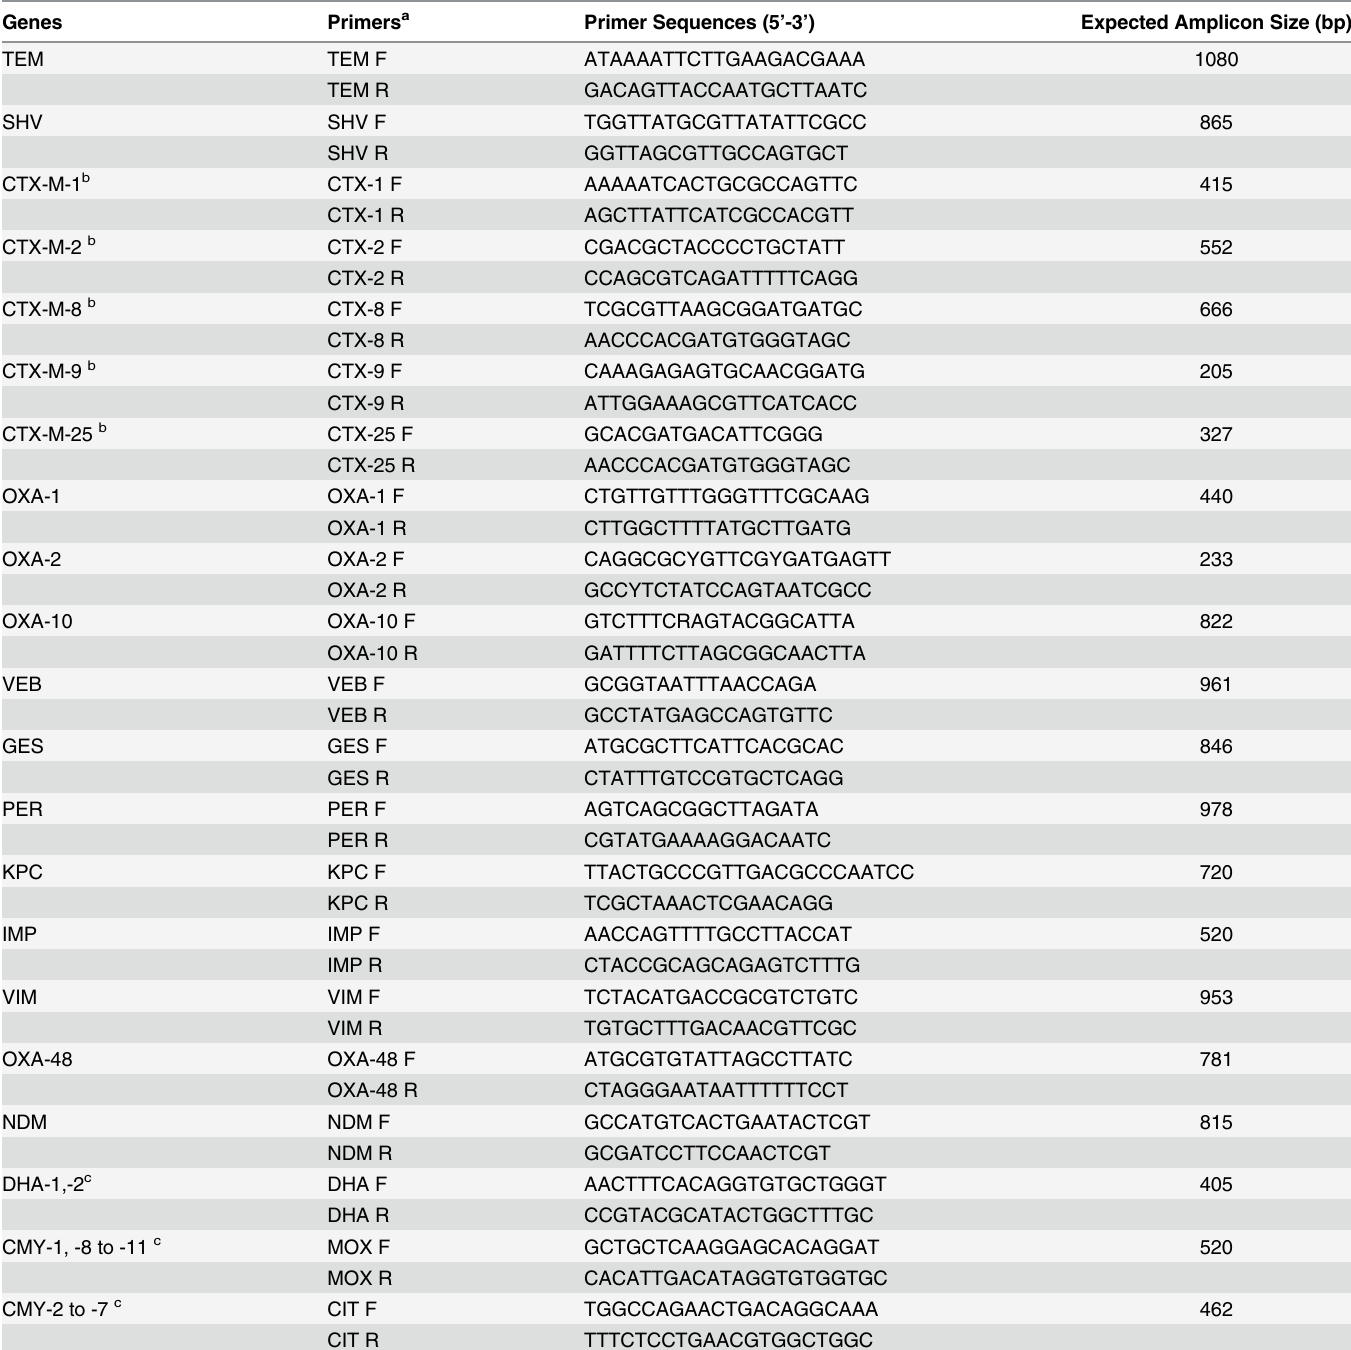
Table 1. Sequences of primers for resistance genes PCR